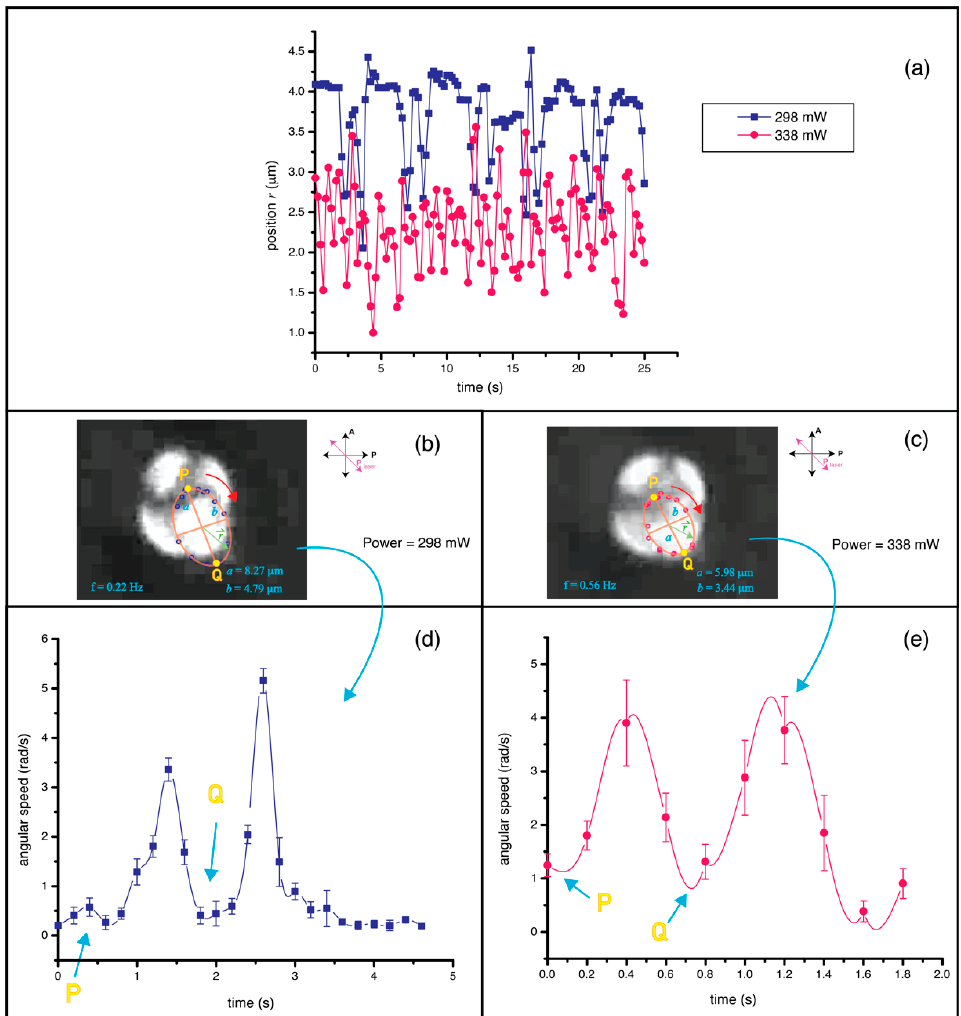
Figure 4. ( a ) Plot of the radial hedgehog defect position of 19- µ m NLC droplet. The position r was measured with respect to the center of the elliptical trajectory (shown in ( b , c )), during clockwise rotation at 298 mW and 338 mW. The period of rotation was 4.54 s and 1.79 s for 298 mW and 338 mW, respectively. ( b , c ) Tracking of the elliptical trajectory of the defect showing non-uniform angular speed. ( d , e ) Angular speed of the defect at 298 mW and 338 mW, respectively. The defect rotation was very slow at points P and Q along the direction of laser polarization for 298 mW laser trapping. The effect is less severe for higher laser power.